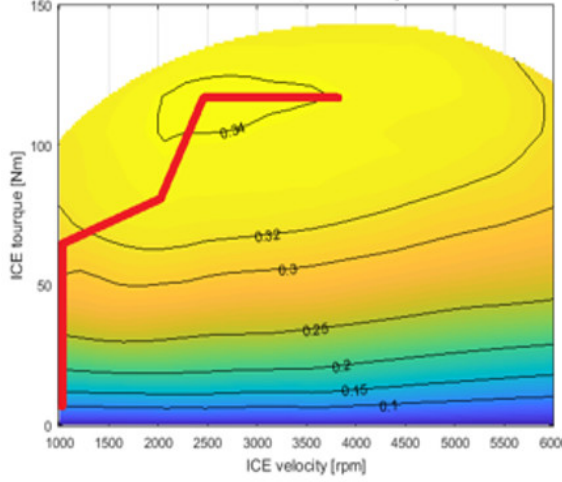
Figure 7. ICE operating points (optimal).